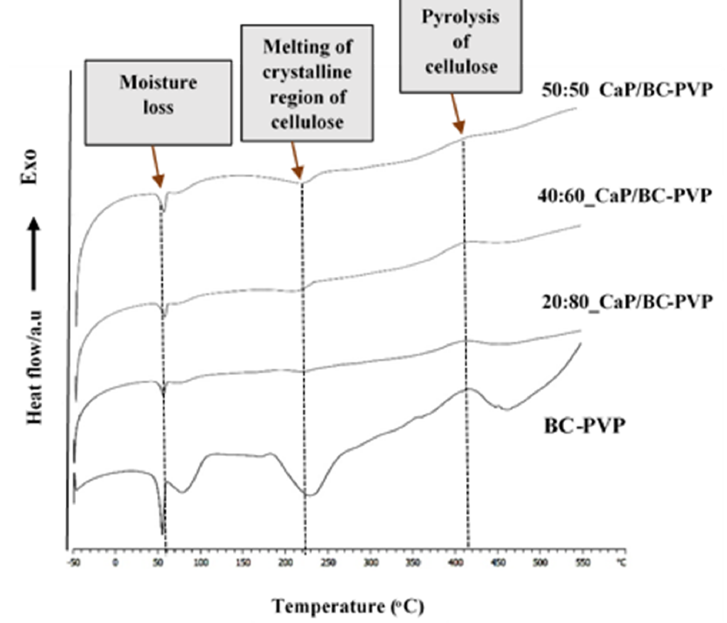
Figure 2. Thermal characterization of calcium phosphate incorporated BC based hydrogel